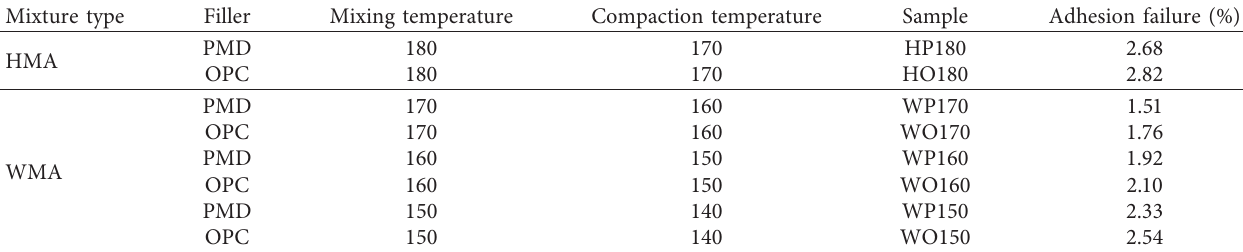
Table 16: Computation for percentage of adhesion failure for dry condition.